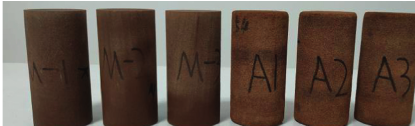
Figure 2: Two groups of red sandstone samples with different